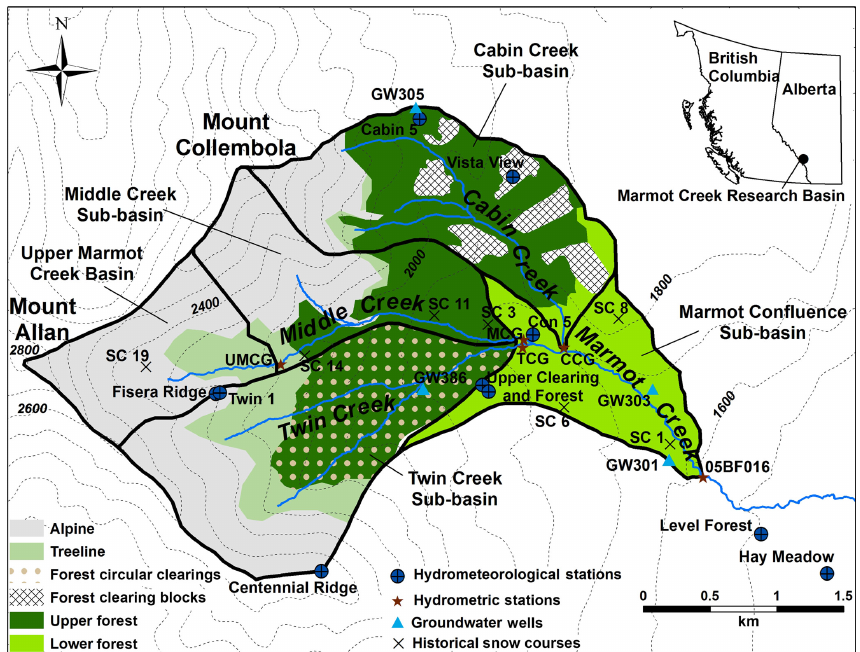
Figure 1. Location and contour map of the Marmot Creek Research Basin (MCRB), showing hydrometeorological stations, hydrometric stations, groundwater wells and snow courses, and ecozones of the MCRB: alpine, treeline, upper forest, forest clearing blocks, forest circular clearings, and lower forest. Note that the size and areas of circular clearings in Twin Creek are not to scale.